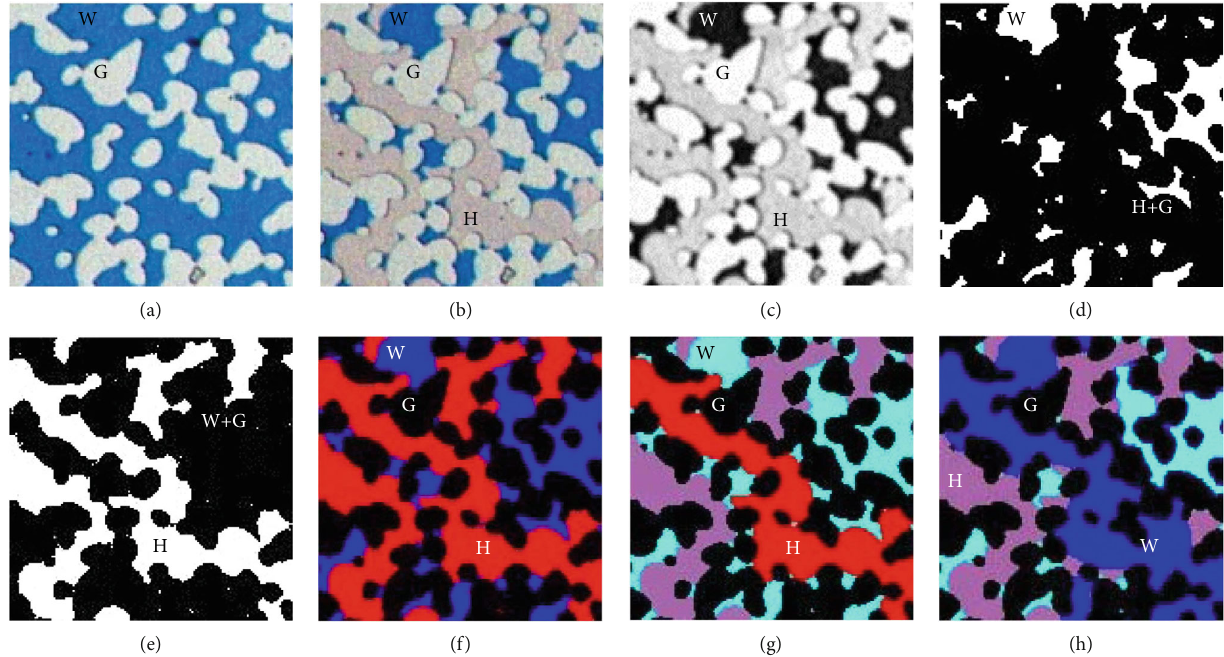
Figure 4: Image processing procedure (W: water; H: hexane; G: glass): (a) a raw image (initially saturated with water), (b) a raw image (saturated with water and hexane), (c) the grey image of (b), (d) the binary image of (c) (after applying threshold, W and H+G), (e) the binary image from (d) subtracting the binary image of (a) (H and W+G), (f) the multicolored image from (d) and (e) (hexane in red and water in blue), (g) the multicolored image from (f) in a drainage cycle (immobile hexane in purple and immobile water in cyan), and (h) the multicolored image from (f) in a imbibition